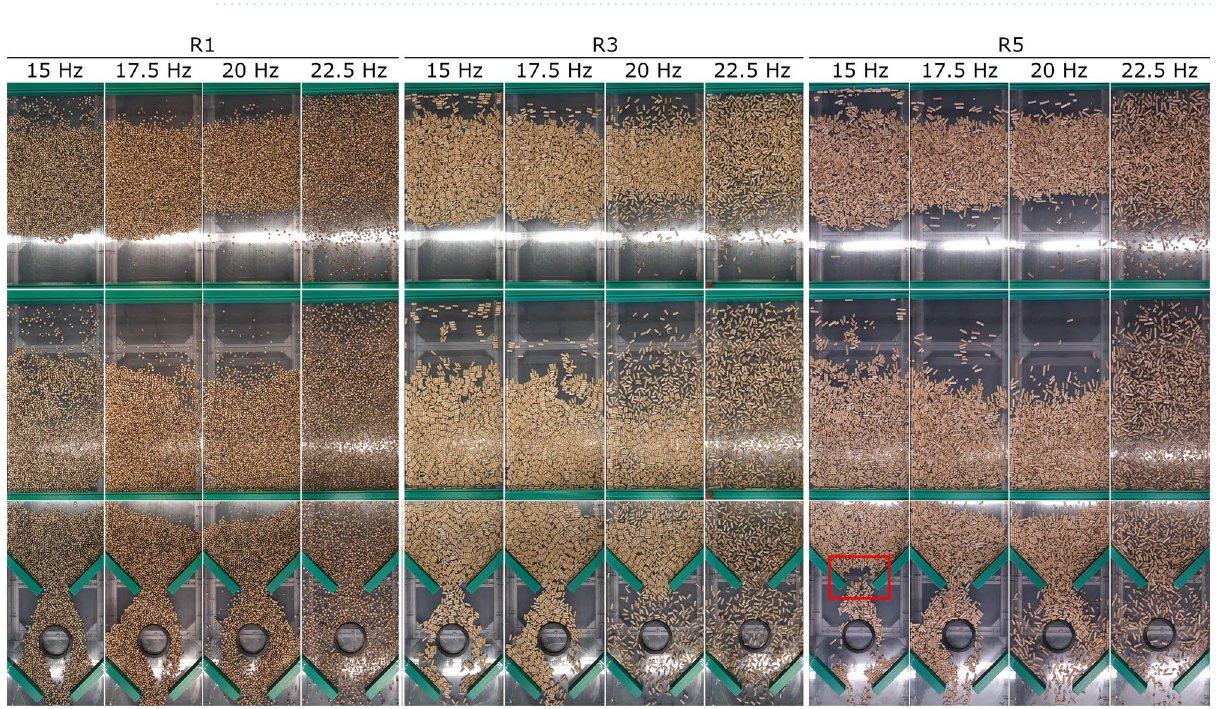
Figure 18. Pattern formation in real-time measurements of pellet transport speed depending on vibration frequency and pellet length.